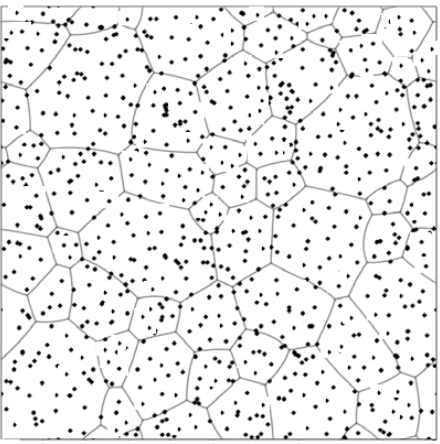
Figure 1. A schematic microstructure showing grains with randomly dispersed nanoparticles in both grain interiors and grain boundaries. Solid lines are grain boundaries, and dark dots are nano-particles.